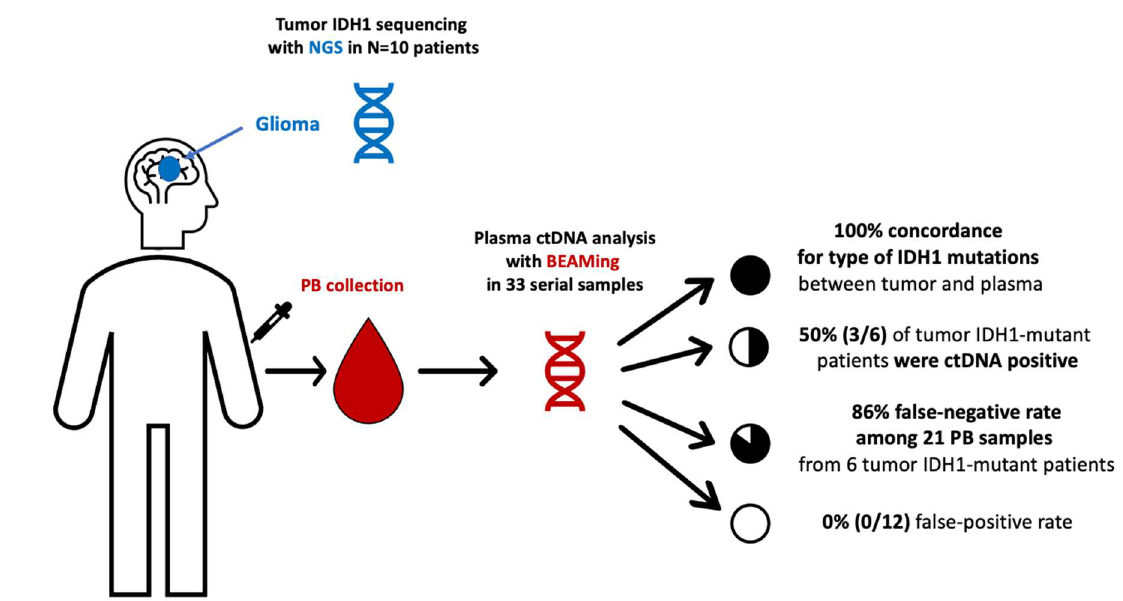
Figure 4. BEAMing ctDNA plots showing the IDH1 mutations detected and their respective VAF Red squares and black arrows indicate the mutant fraction within the BEAMing plot. BEAMing: Beads, Emulsion, Amplification and Magnetics, IDH1: isocitrate dehydrogenase type 1, VAF: variant allele frequency.